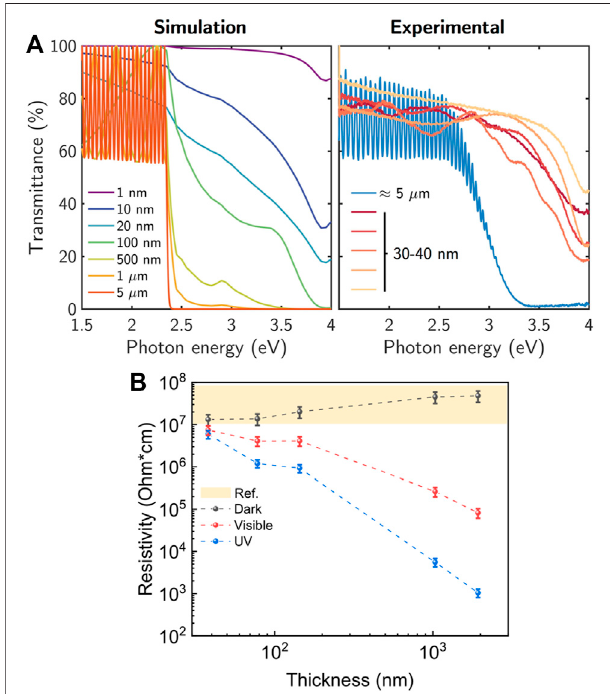
FIGURE 4 | (A) Calculated and measured transmittance as a function of the GaS thickness. (B) Thickness dependence of the resistivity of GaS layers under dark, visible-, and UV-light irradiation. For comparison, the yellow shadowedareaindicatestherange ofthedark resistivityvaluesreported in literature for GaS (Manfredotti et al., 1976; Mancini et al., 1983; Micocci et al., 1990; Sza ł ajko and Nowak, 2007).